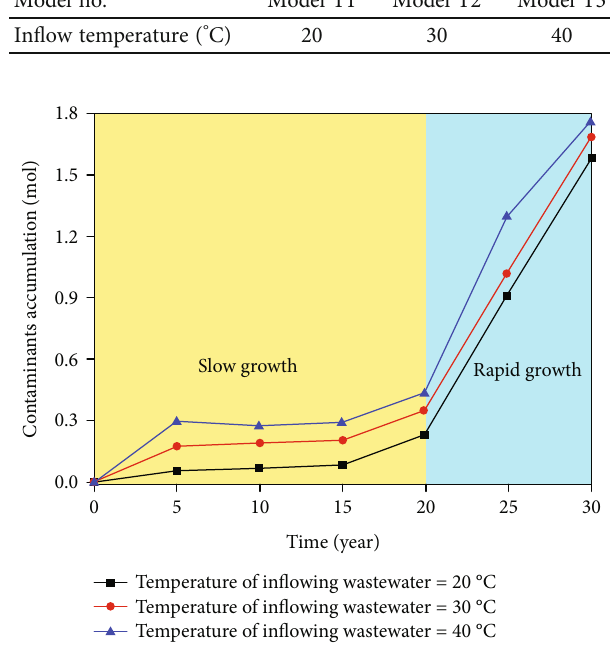
Figure 16: The contaminant accumulation along the line of CD under di ff erent permeability. Table 6: The temperature of the in fl ow wastewater. Model no.